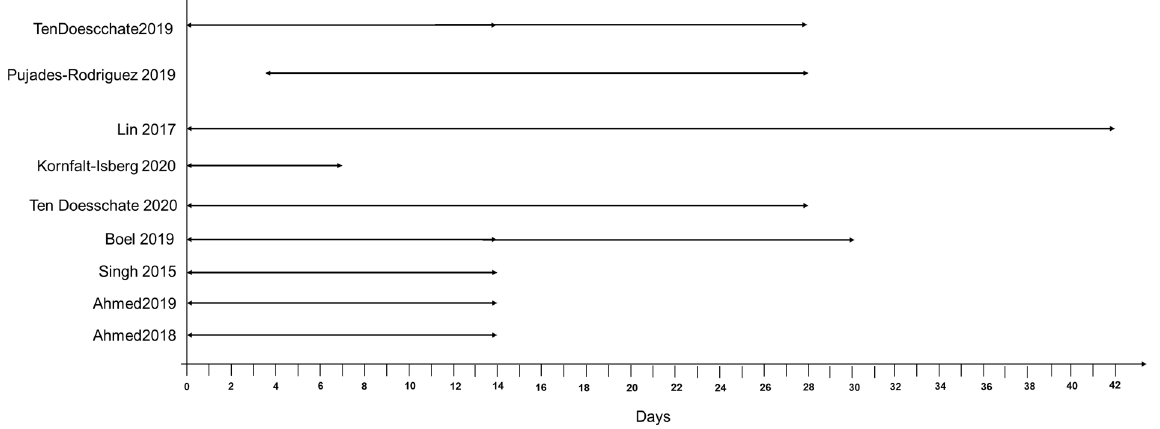
Figure 4. Time in days for ascertaining prescription change attributable to treatment failure in UTI studies.